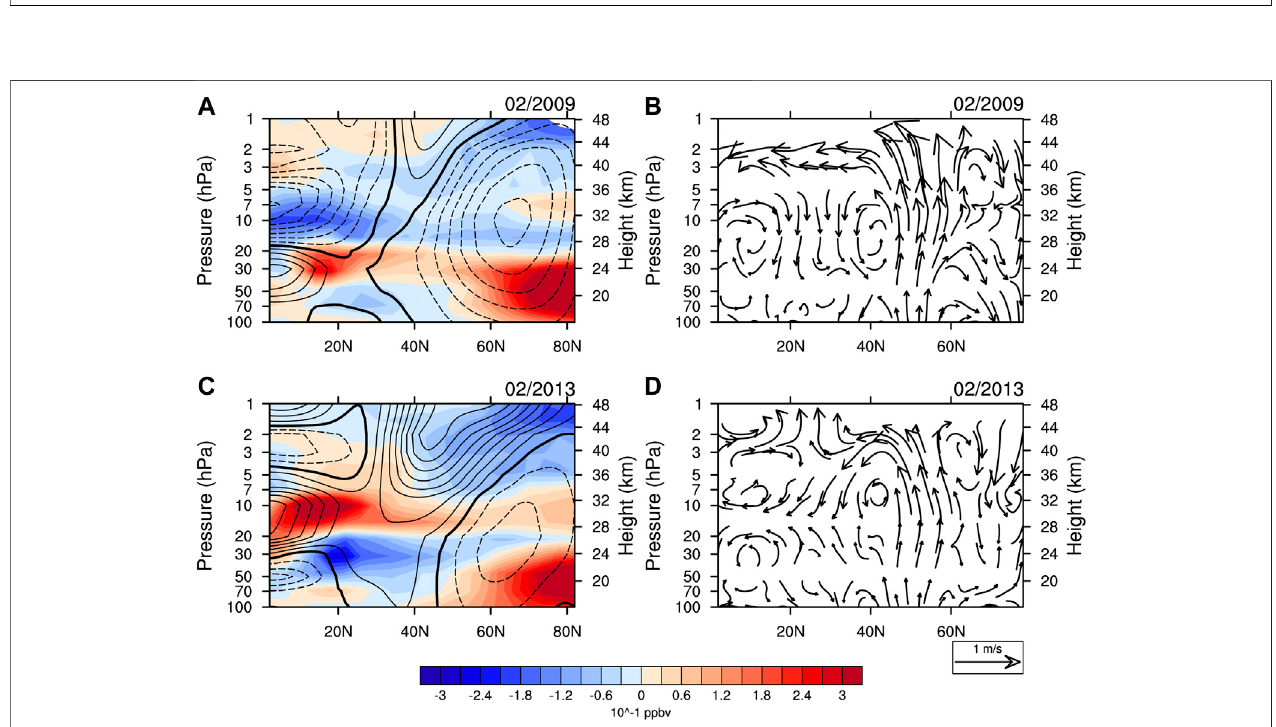
FIGURE 10 | (A,C) Anomalies ofHCl inthe NorthernHemispherestratosphere (colorshading,units:10 – 1 ppbv) and zonal-meanzonal wind(U, contours,interval is4 m s − 1 )in (A) February2009and (C) February2013.ThinsolidlinesrepresentpositiveU,dottedlinesarenegativeU,andthethicksolidlinerepresentsthezeroline. (B,D) The residual circulation ( v p , w p ) anomalies in (B) February 2009 and (D) February 2013. The vertical component of the residual circulation ( w p ) has been multiplied by 500.